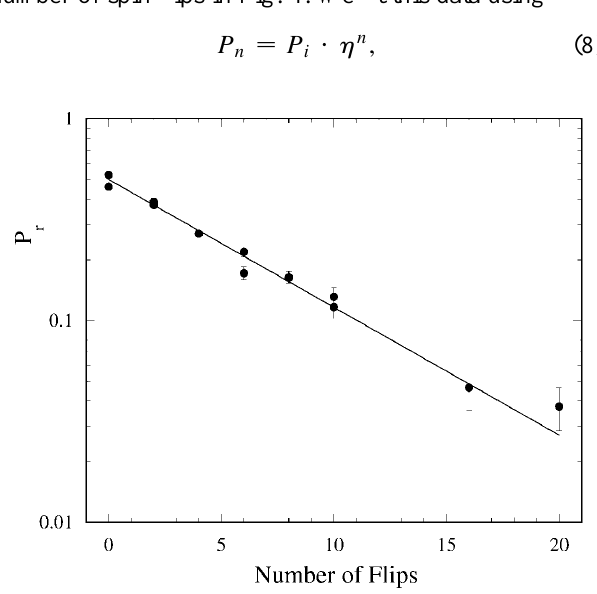
FIG. 4. The measured radial proton polarization at 120 MeV is plotted against the number of spin flips. The rf dipole’s frequency ramp time D t was 400 msec, its frequency range D f R B dl was 0.06 T mm. The curve is a fit to was 10 kHz, and its the data using Eq.